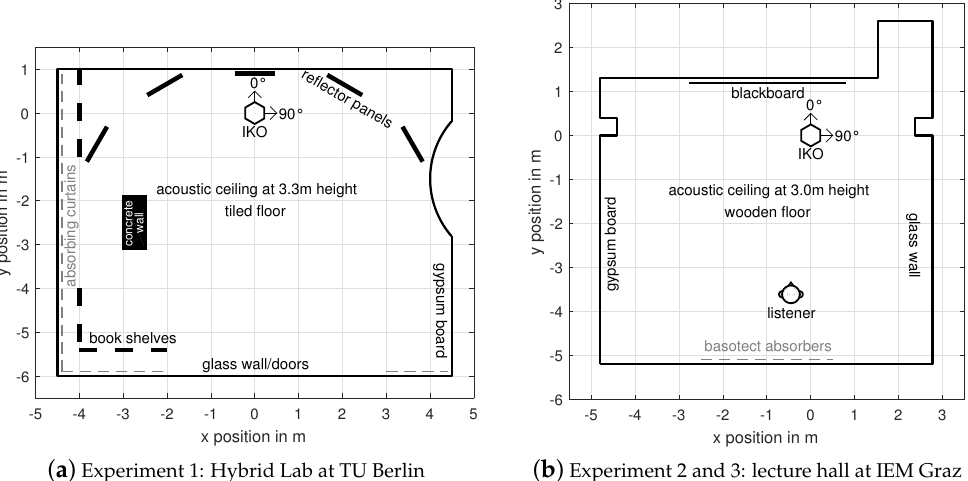
Figure 2. Sketch of the experimental